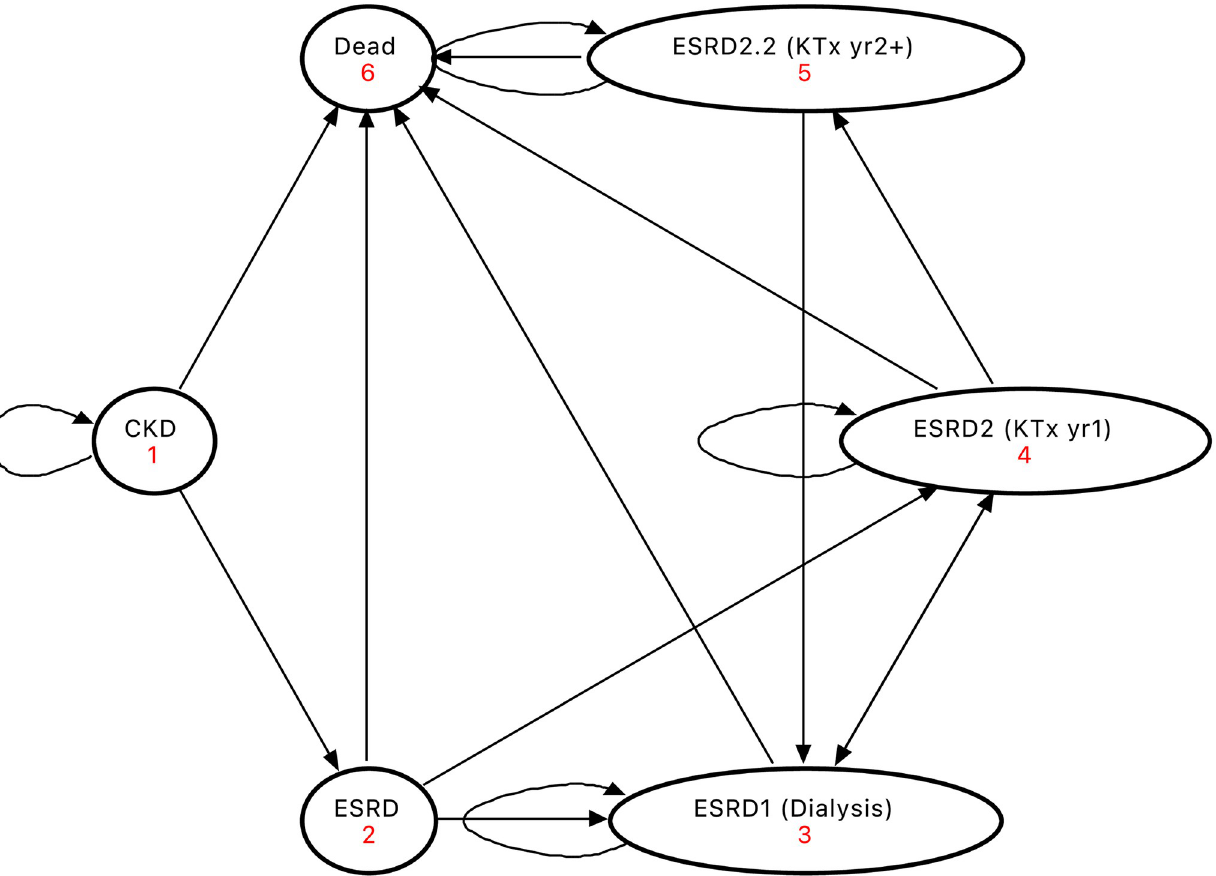
Fig 1. Markov model diagram. ESRD1 refers to Dialysis and ESRD2 refers to Kidney Transplant (KTx); ESRD2 is divided into year 1 (ESRD2) and subsequent years (ESRD2.2) to account for reduced costs after first post-transplant year. CKD—Chronic Kidney Disease; ESRD–End Stage Renal Disease; KTx–Kidney